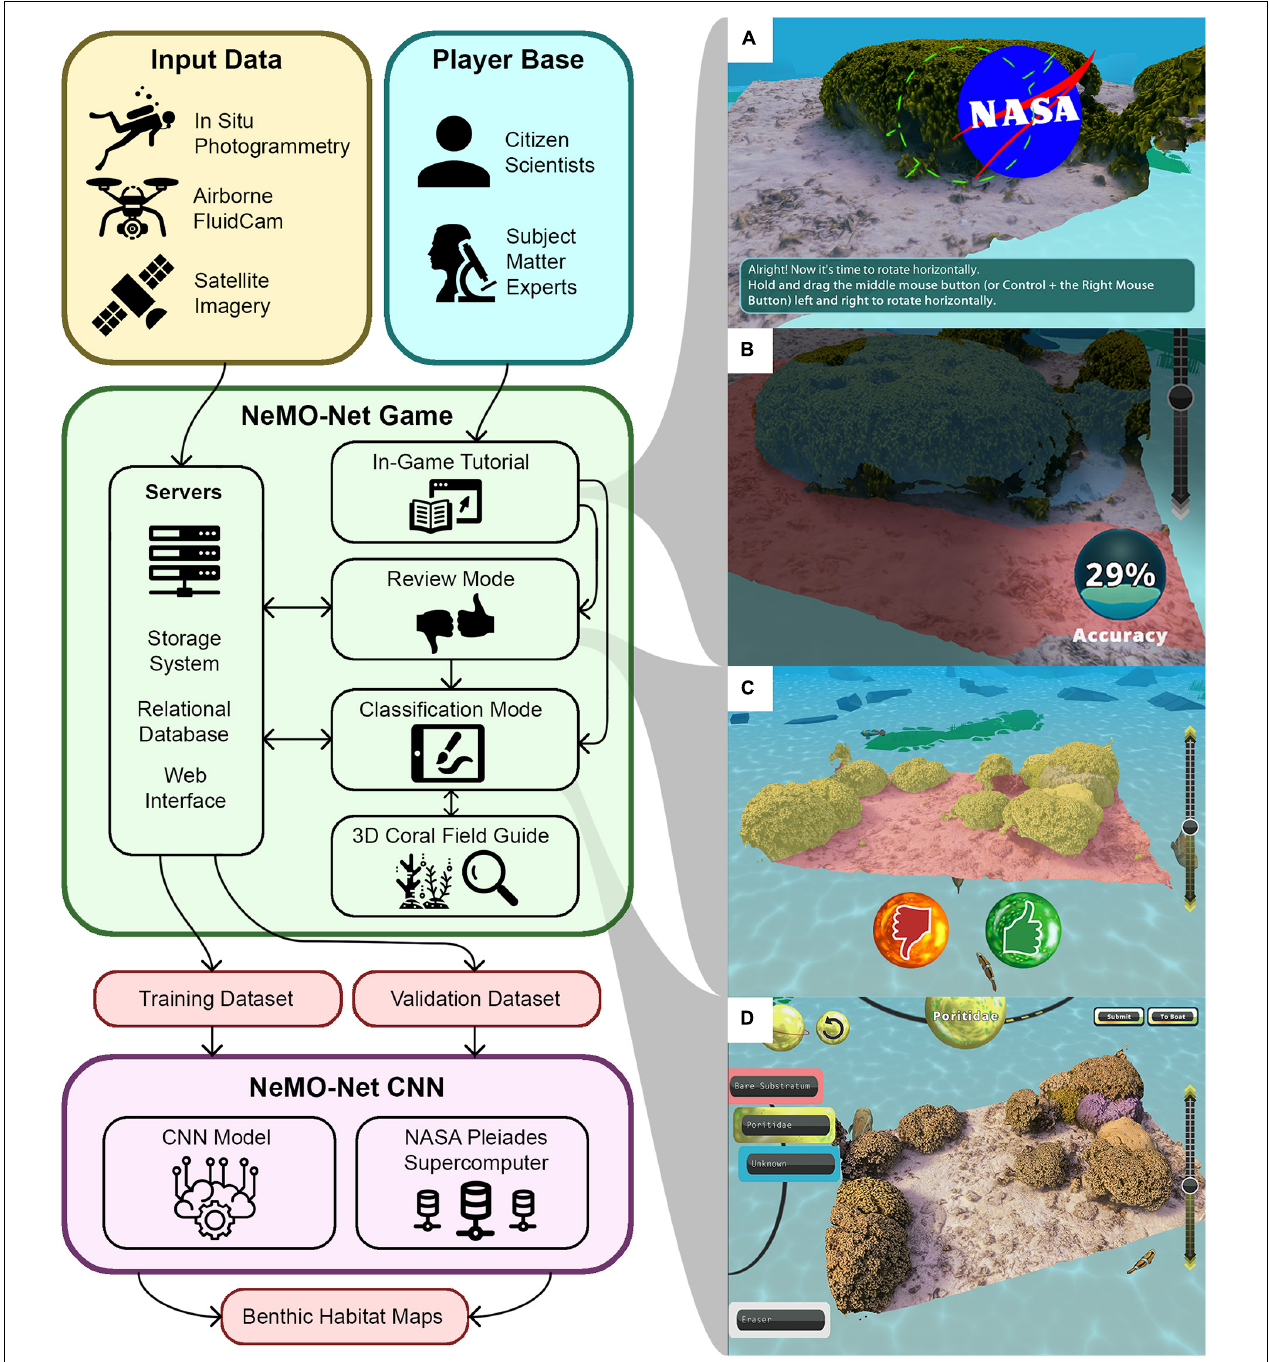
FIGURE 3 | NeMO-Net video game overview. (A) In-game tutorial testing players’ 3D navigation skills. (B) In-game tutorial testing 3D painting skills, players must pass an accuracy threshold to continue. The player in this figure is currently at 29% accuracy for this training example. (C) Review mode allows players to rate other players’ classifications. (D) Classification mode allows players to create and edit